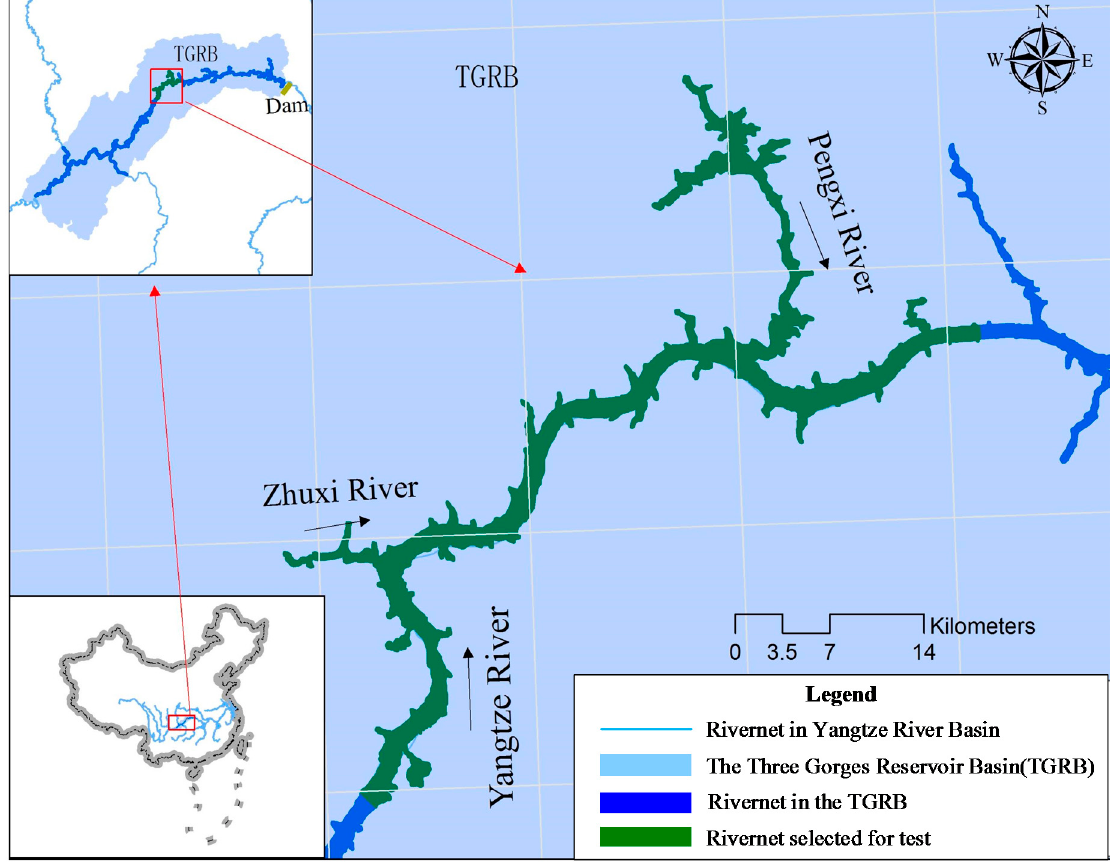
Figure 5. Geographic location and river network selected in the Three Gorges Reservoir